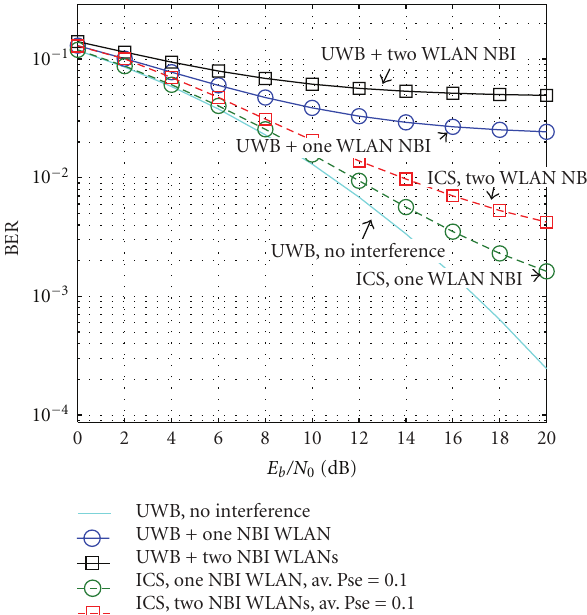
Figure 6: BER performance of the ICS in the presence of two NBI WLANs in a Log-normal flat fading channel, SIR = − 10 dB.